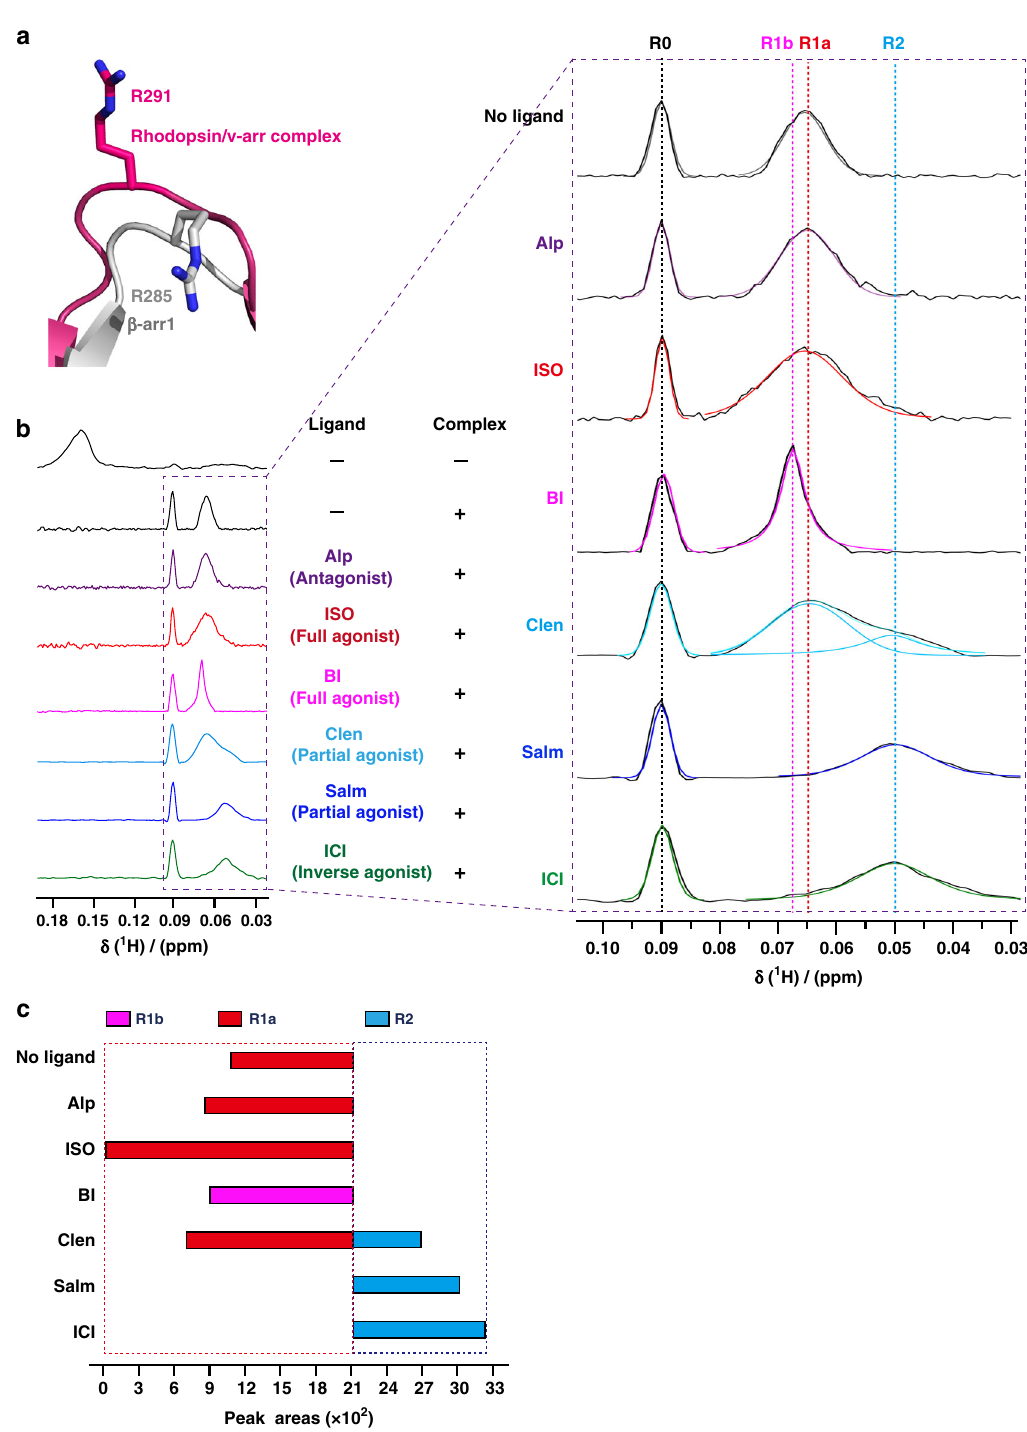
Fig. 6 Monitoring the conformational states of site 285 of β -arr1. a Structural comparison of the R285 position in inactive β -arr1 (PDB: 1G4M) and the corresponding R291 position in the rhodopsin/arrestin complex (PDB: 5W0P). The active β -arr1 structure is depicted in gray, and the rhodopsin/arrestin complex is in red. The activation of arrestin by a receptor led to a highly solvent-exposed con fi guration at the R285 position of β -arr1, as suggested by the crystal structures. b 1D 1 H NMR spectra of β -arr1 R285TMSiPhe activated by pp β 2V2R with or without different ligands. After incubation with pp β 2V2R, multiple new NMR signals appeared between 0.04 ppm and 0.10 ppm, which are designated as R0 (0.09 ppm), R1a (0.065 ppm), R1b (0.068 ppm), R2 (0.05 ppm), from low fi eld to high fi eld. The buffer used for the experiment contained 20 m M HEPES, 150 m M NaCl, 0.01% LMNG, 0.002% CHS, and 10% D 2 O (pH = 7.5 at 25 °C). + : receptor- β -arr1 complex; − : β -arr1 alone. c Bar graph representing the population (simulated peak area) of each NMR peak for each ligand condition. The values are also tabulated in Supplementary Fig.